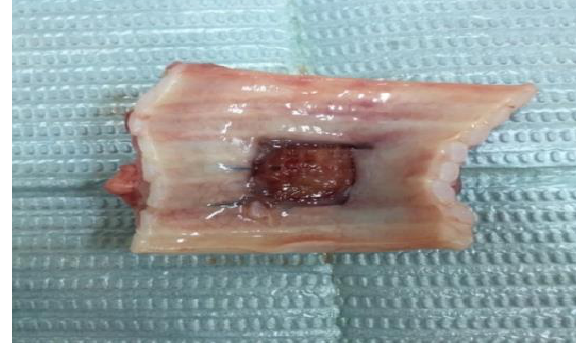
Figure, 7: Shows tracheal defect of dog was still appeared at 15 postoperative day in G1 (polypropylene mesh and bone cement).